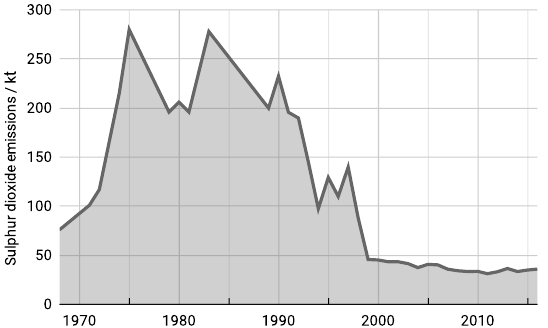
Figure 4. Development of sulphur dioxide (SO 2 ) emissions from the Severonikel smelter [45–47]. Similarly to Figure 3, we use a wider range of dates to demonstrate the long-term